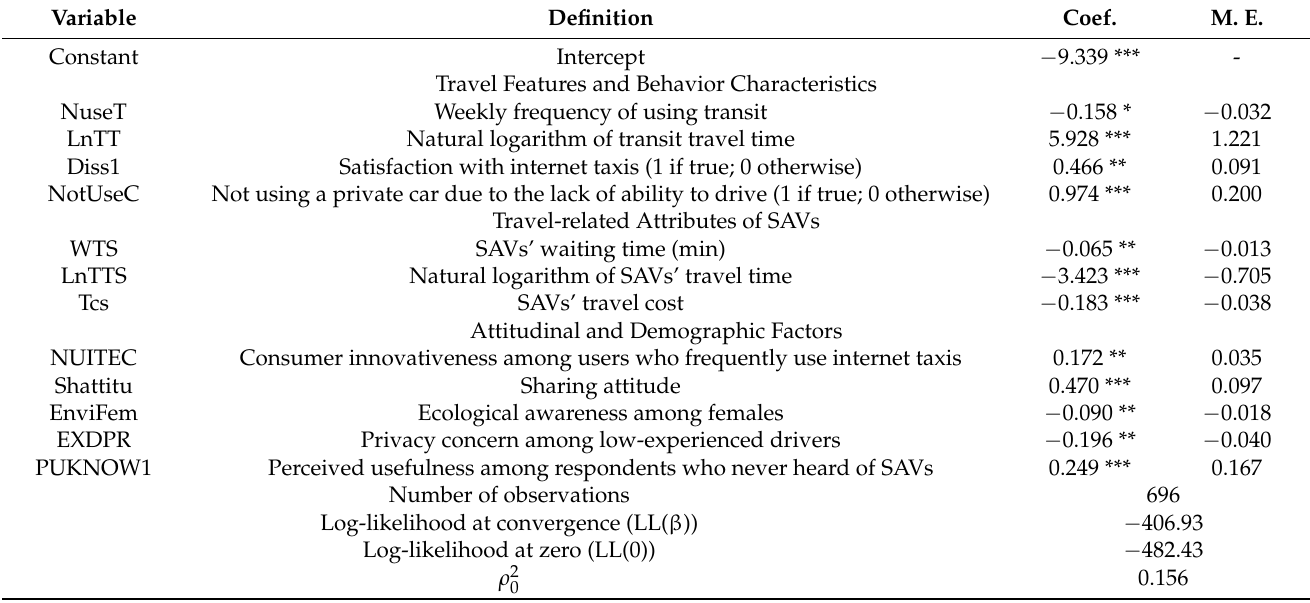
Table 7. Estimation results of binary logit model of modal shift preference of transit users.